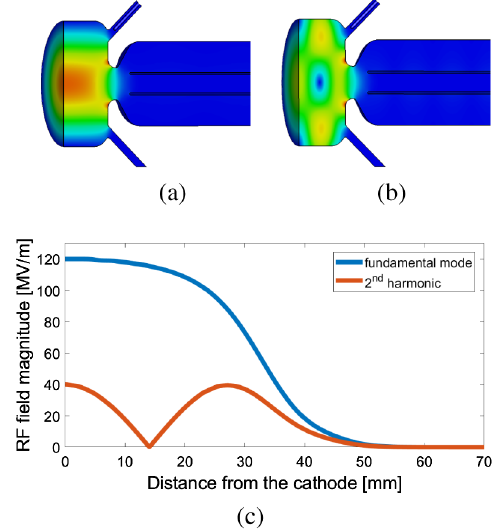
FIG. 1. The electric field distribution of the both modes in CST simulation. (a) The fundamental TM 010 mode at 2856 MHz. (b) The harmonic TM 011 mode at 5712 MHz. (c) The on-axial E z distribution of fundamental mode and 2nd harmonic